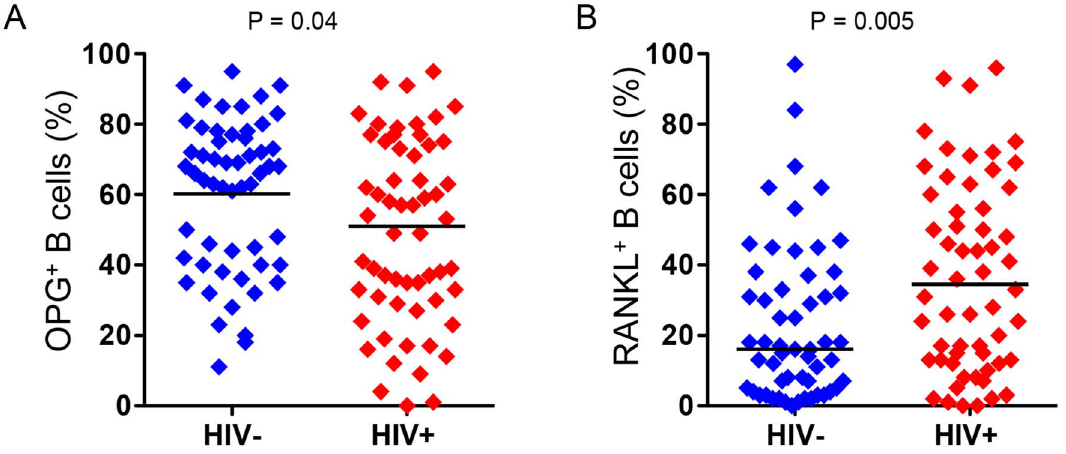
Figure 1. Increased frequency of RANKL-expressing B cells and decreased frequency of OPG-expressing B cells in HIV infection. Intracellular expression of: A) OPG and B) RANKL, by circulating peripheral blood B cells were quantified by flow cytometry in 56 HIV-negative and 57 HIV-infected individuals. Comparisons between HIV sero status were performed using Wilcoxon rank-sum test. doi:10.1371/journal.ppat.1004497.g001 PLOS Pathogens |